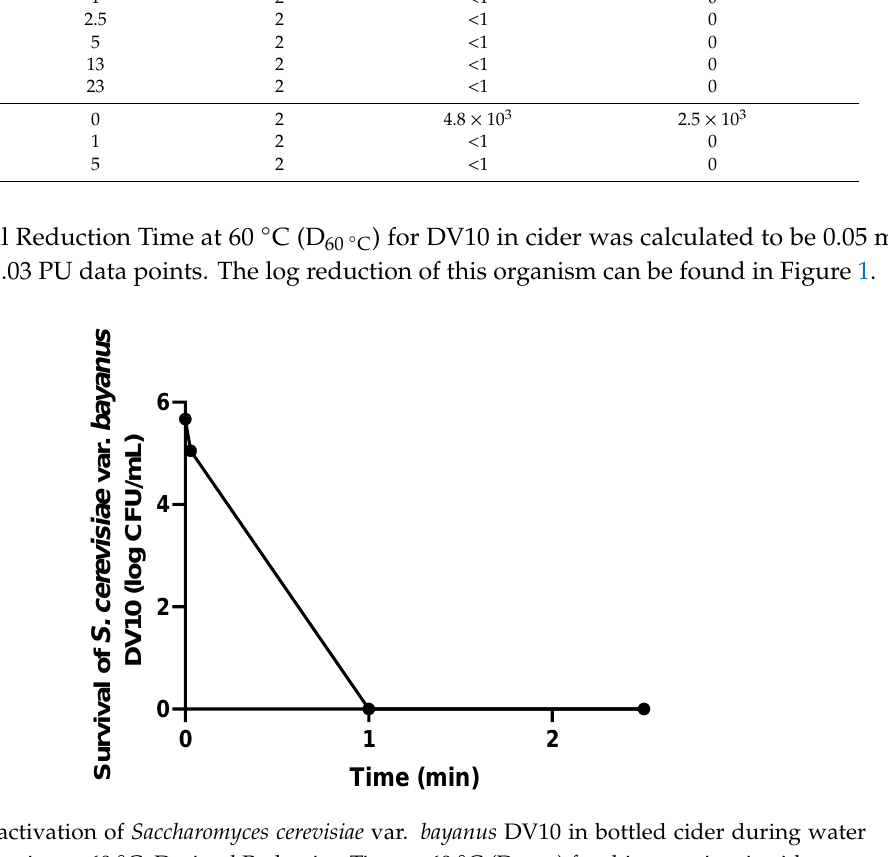
Table 2. Effect of various applications of pasteurization units (Pus) on yeast populations for water bath pasteurized bottled ciders.